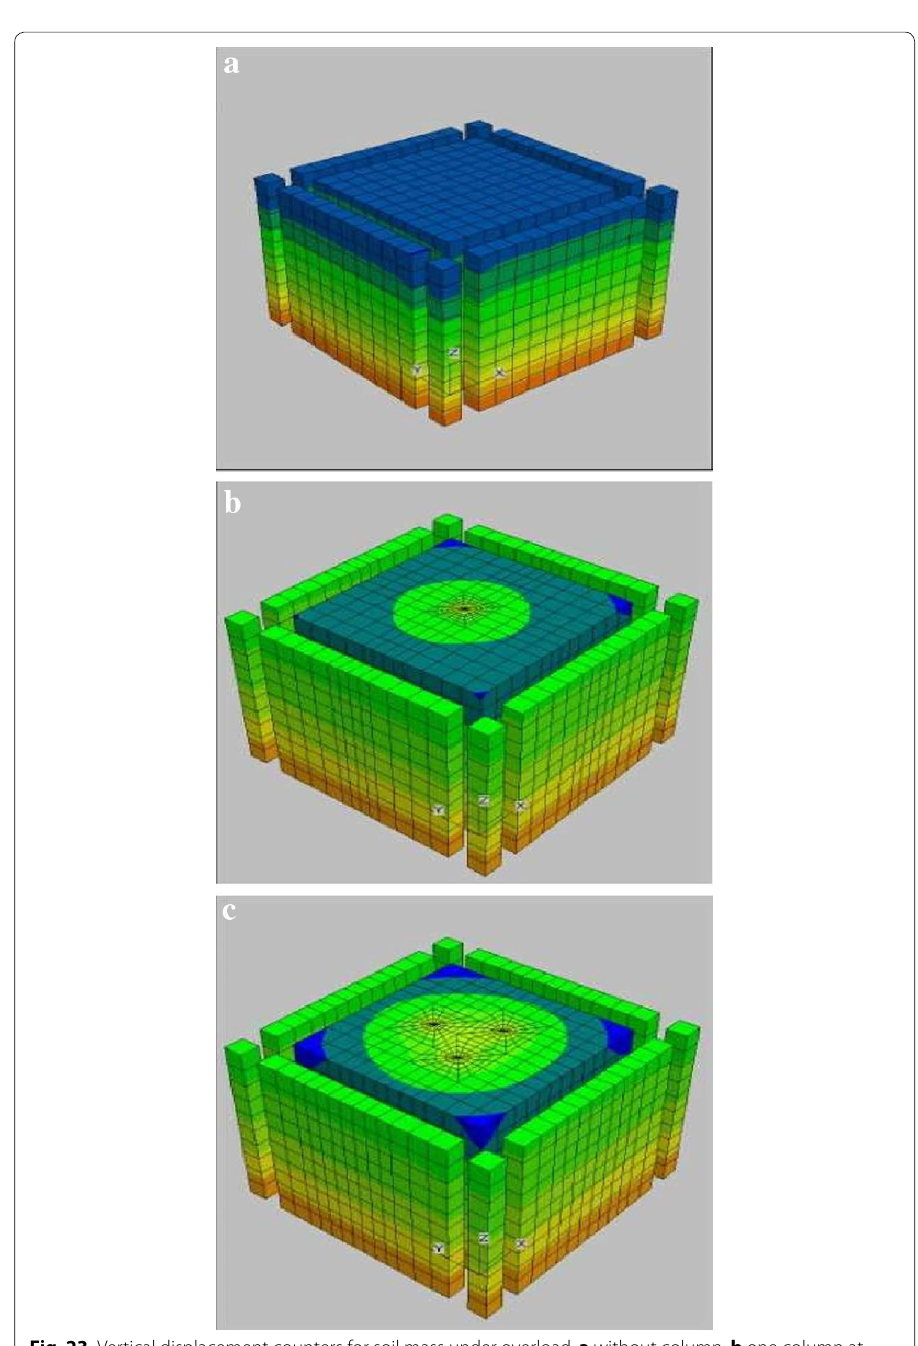
Fig. 23 Vertical displacement counters for soil mass under overload, a without column, b one column at center, c column